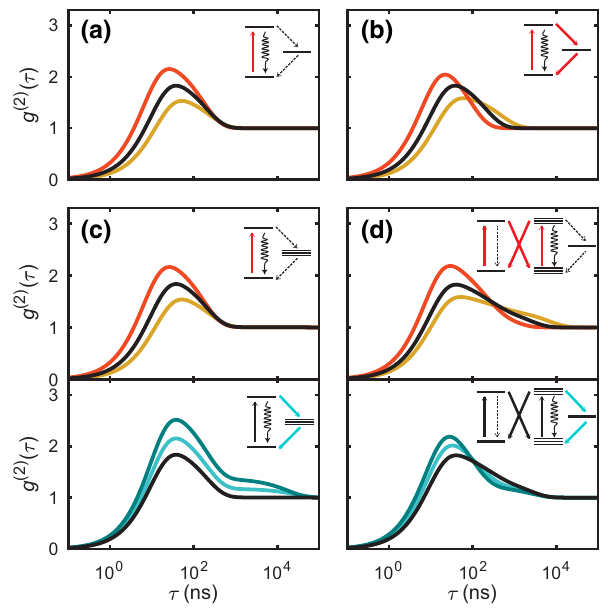
FIG. 5. Simulated g ( 2 ) traces for four different physical mod- els. The effects of increasing (red) or decreasing (yellow) the excitation power and a lower (light blue) or higher (dark blue) angle of the magnetic field on g ( 2 ) (τ) vary depending on the model. (a) The three-level model with a pumped transition (solid red arrow) to the excited state and fixed nonradiative transition rates (dashed arrows) to a metastable state. (b) The three-level model with power-dependent transitions (solid red arrows) to and from a metastable state. (c) The five-level model with a pumped transition to the singlet excited state and spin-dependent tran- sitions (blue arrow) to and from a metastable spin triplet. (d) The nine-level model of a NV center with both spin-dependent and power-dependent transitions. Radiative transitions are shown as wiggly arrows. The insets in (c) and (d) show the effects of changing power (top inset) and magnetic field angle (bot- tom inset) separately for each model. The yellow, black, and red curves in (a)–(c) depict excitation pump rates, respectively, half, equal to, and double the radiative decay rate of each model. The magnetic field parameters are chosen in order to qualitatively represent different degrees of spin mixing, with black, light blue, and dark blue curves corresponding to zero, medium, and high- spin mixing, respectively. The black curves are identical between the top and bottom insets, and the parameters are chosen such that the black curves for each model are qualitatively the same across (a)–(c) and approximate the amplitude and peak position of (d). More detail on the simulation parameters can be found in Table